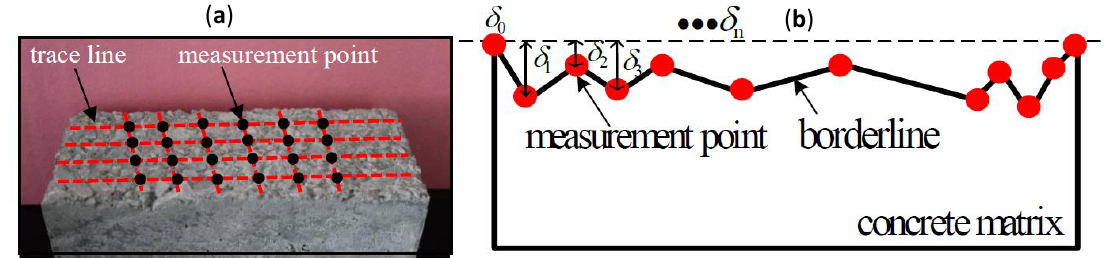
Figure 3. Trace lines, measurement points and getting points in the bond area. ( a ) the total measurement points for one specimen; ( b ) a contour line in the rough concrete surface.